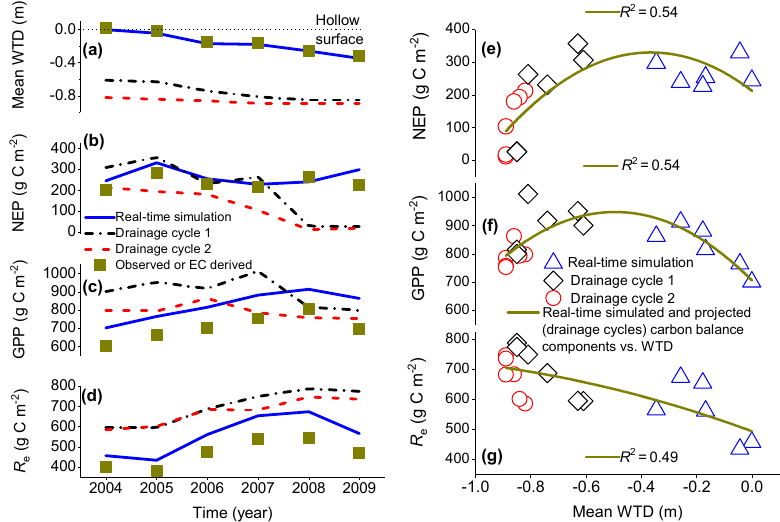
Figure 9. (a) Observed, simulated (real-time simulation) and projected (drainage cycles 1 and 2) average growing season (May-August) WTD; EC-derived, simulated and projected growing season sums of (b) NEP, (c) GPP and (d) R e ; and regressions ( P < 0 . 001) of simulated and projected sums of (e) NEP, (f) GPP and (g) R e on simulated and projected average growing season WTD during 2004–2009 at a western Canadian fen peatland. A negative WTD represents a depth below hollow surface, and a positive WTD represents a depth above hollow surface. A positive NEP means that the ecosystem is a C sink.